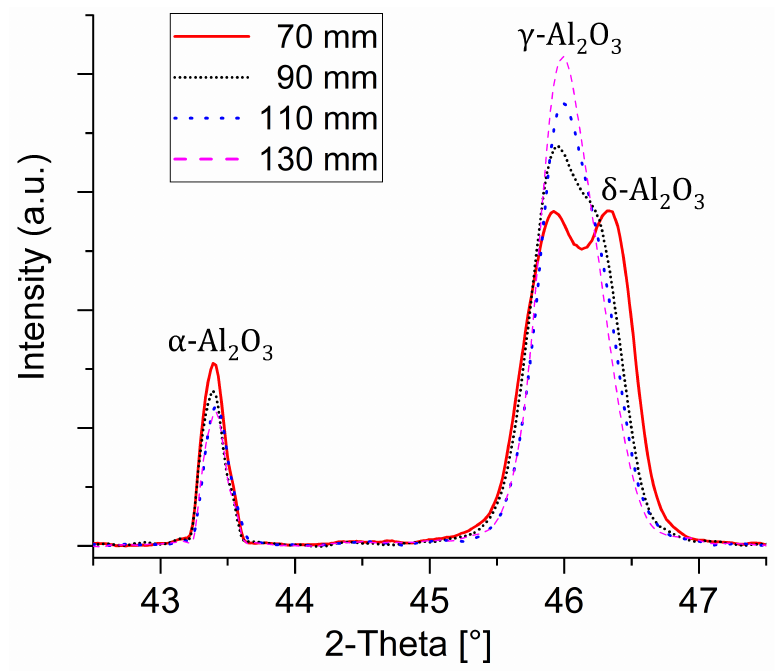
Figure 4. Detailed excerpt from the XRD analysis of Al 2 O 3 samples showing a rising peak at 2 θ (46.3°) toward lower spray